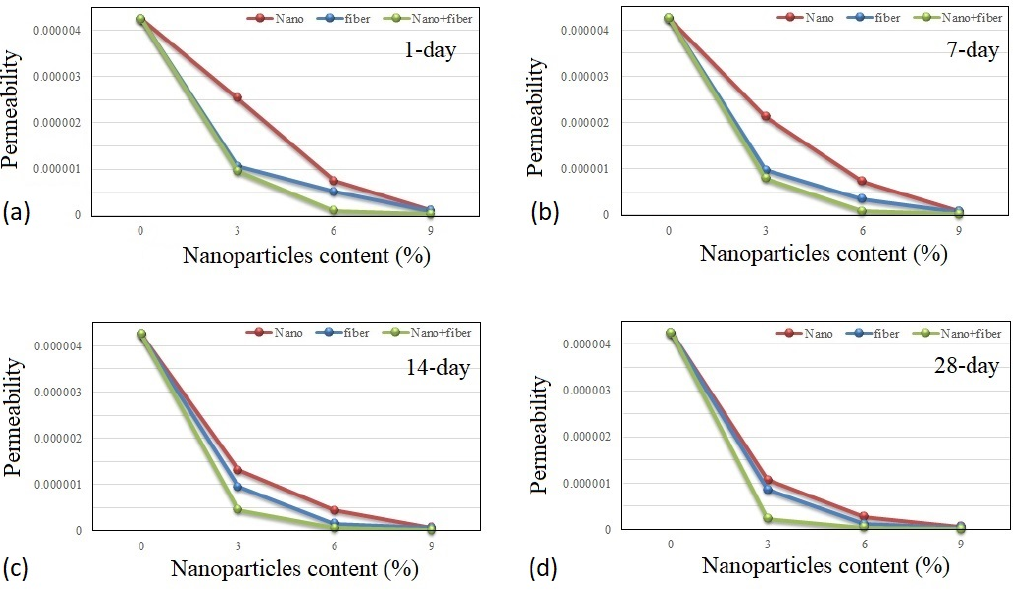
Figure 5. Permeability of studied samples in different groups (unit is cm/s): ( a ) 1-day, ( b ) 7-day, ( c ) 14-day, ( d ) 28-day.